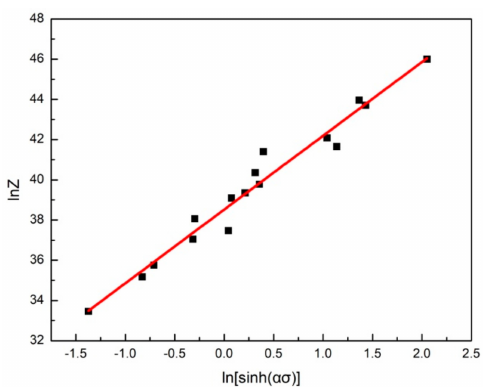
Figure 4. Plot of ln Z vs. ln[sinh( ασ